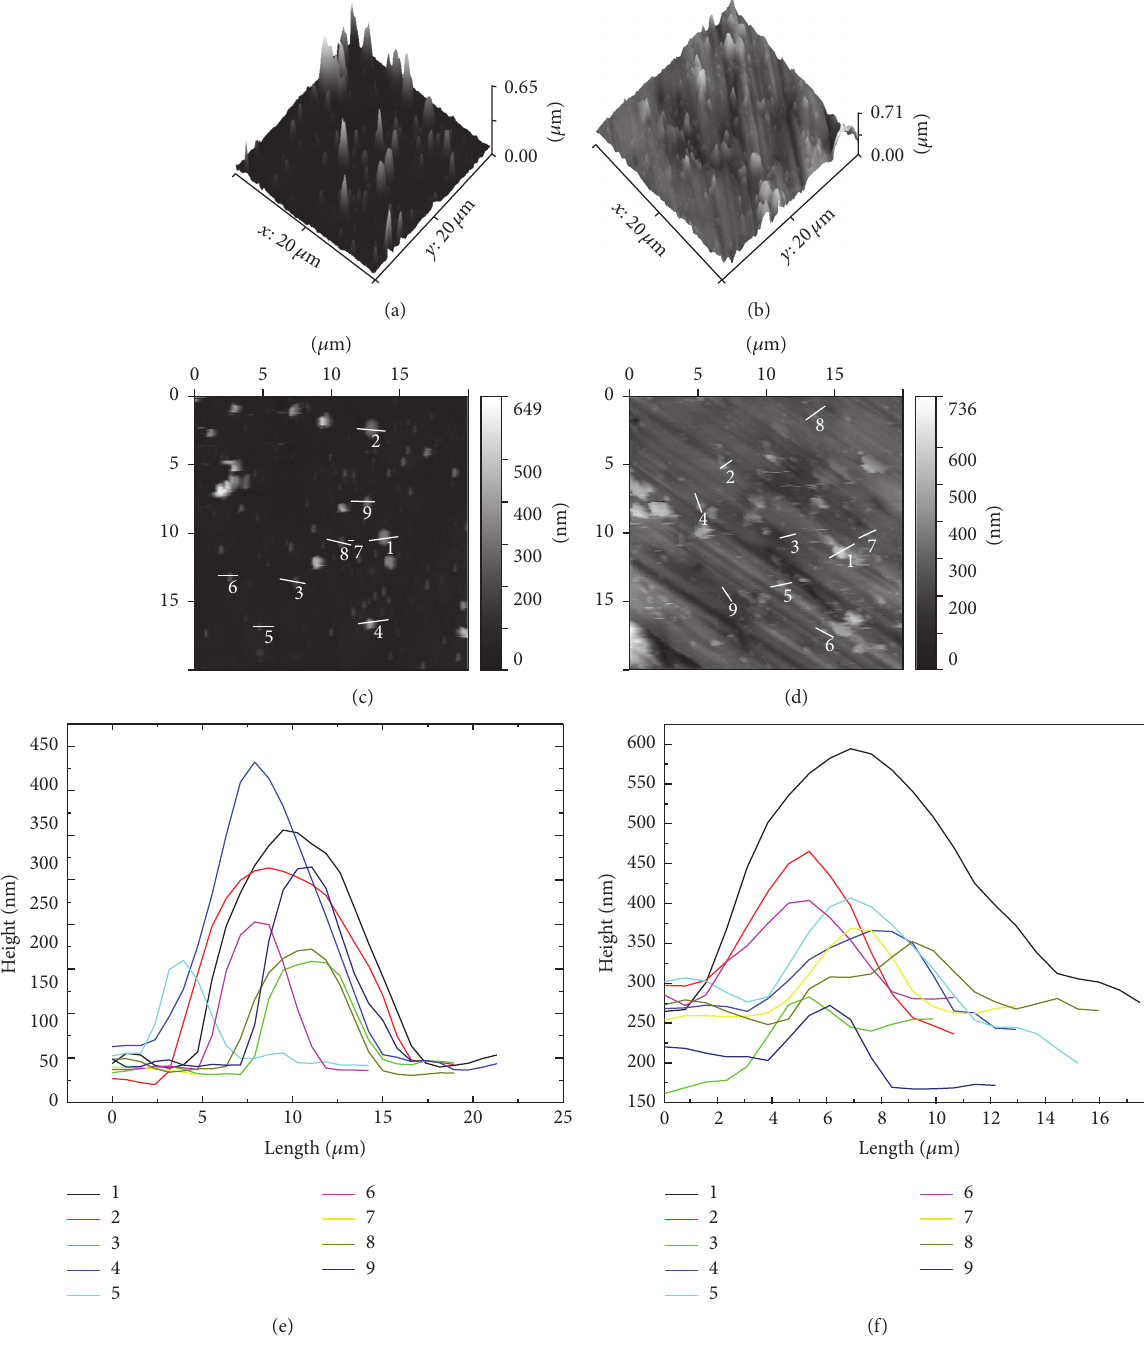
Figure 5: AFM analysis of the samples obtained at irradiation times of (a, c, and e) 2.5 min and (b, d, and f) 10min. (a) and (b) AFM 3D 20 × 20 𝜇 m 2 images; (c) and (d) AFM 2D 20 × 20 𝜇 m 2 images with profiles; (e) and (f) linear profiles of the lines indicated at (c) and